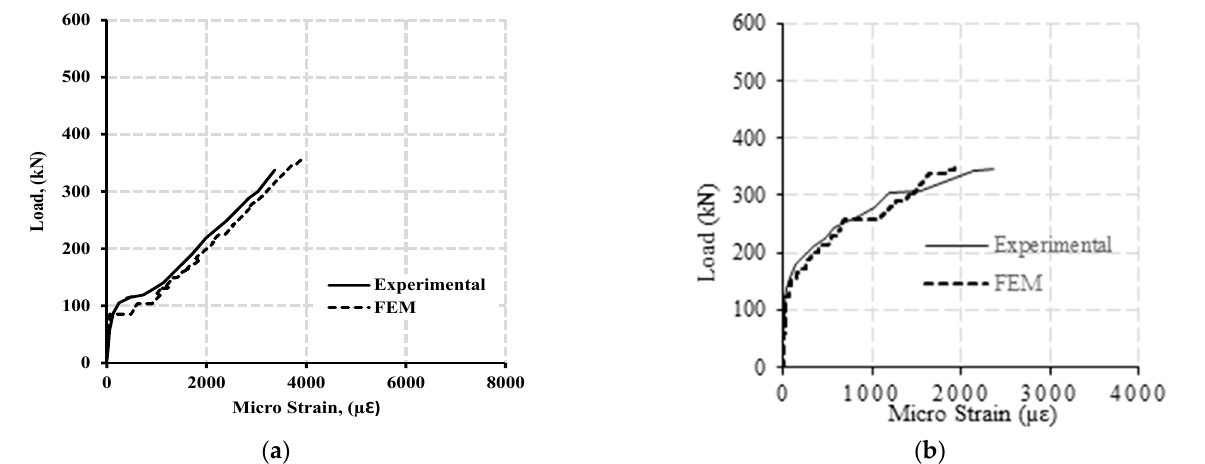
Figure 7. Typical load—strain curve at the hogging moment section of beam specimen GN ‐ 1.2 ‐ 0.48 (with normal concrete strength of 43 MPa) for ( a ) the longitudinal reinforcement and ( b ) stirrup.